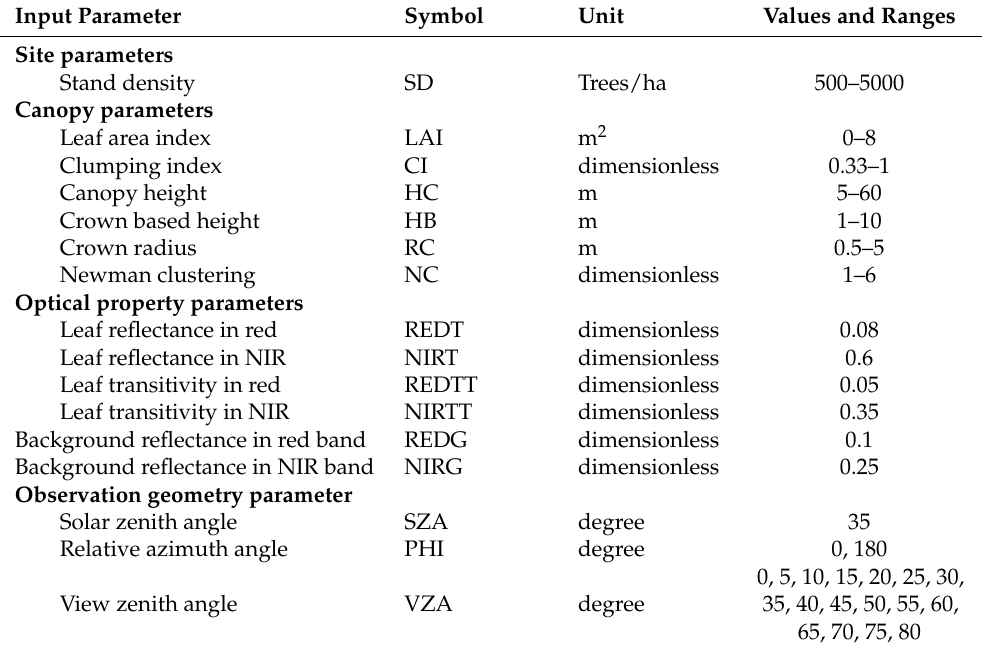
Table 2. Input parameters for 4-scale model, including parameters value and